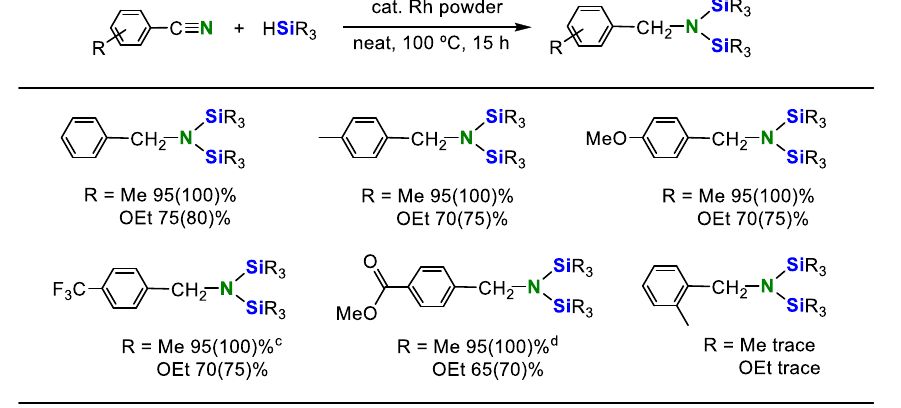
Table 3. Double hydrosilylation of aromatic nitriles promoted by rhodium metal particles a,b .